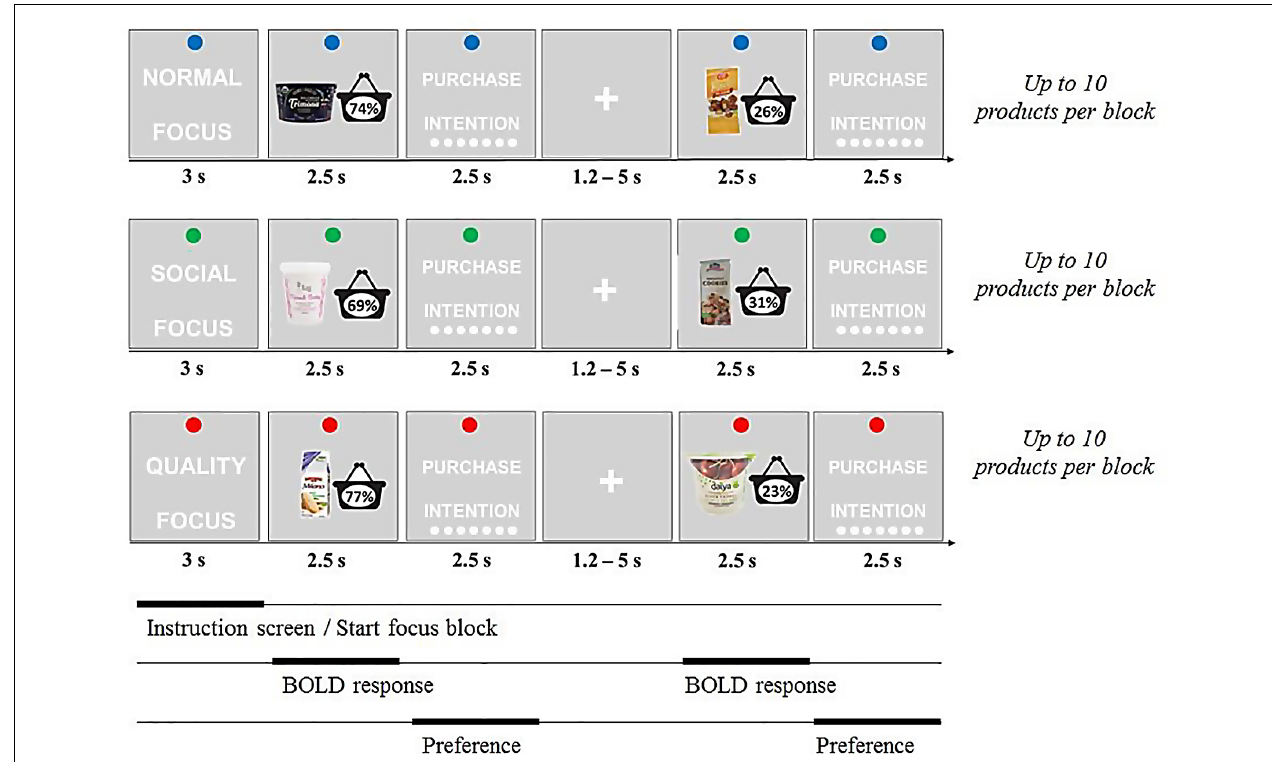
FIGURE 2 | Overview of experimental design. Participants expressed purchase intention in three conditions: (1) normal focus condition, (2) social focus condition, and (3) quality focus condition. Before each block of 10 products, subjects were informed which aspect of the product to pay attention to before making the choice.